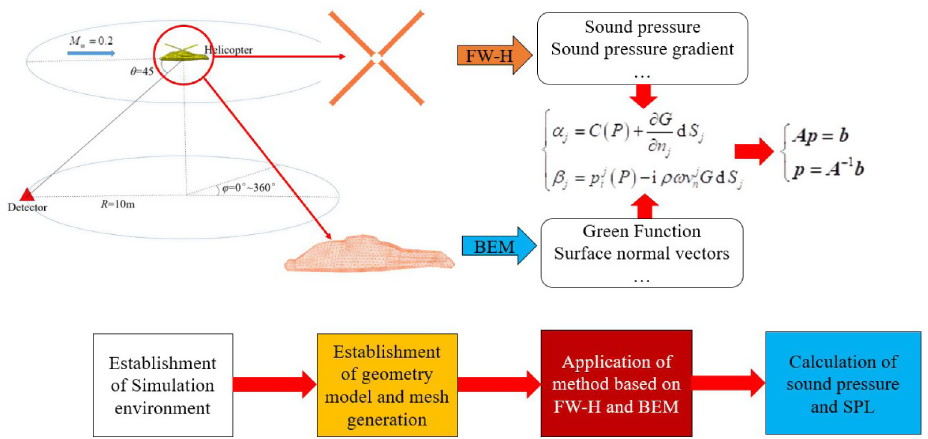
Figure 6. Schematic diagram and fl ow chat of the methodology approach.